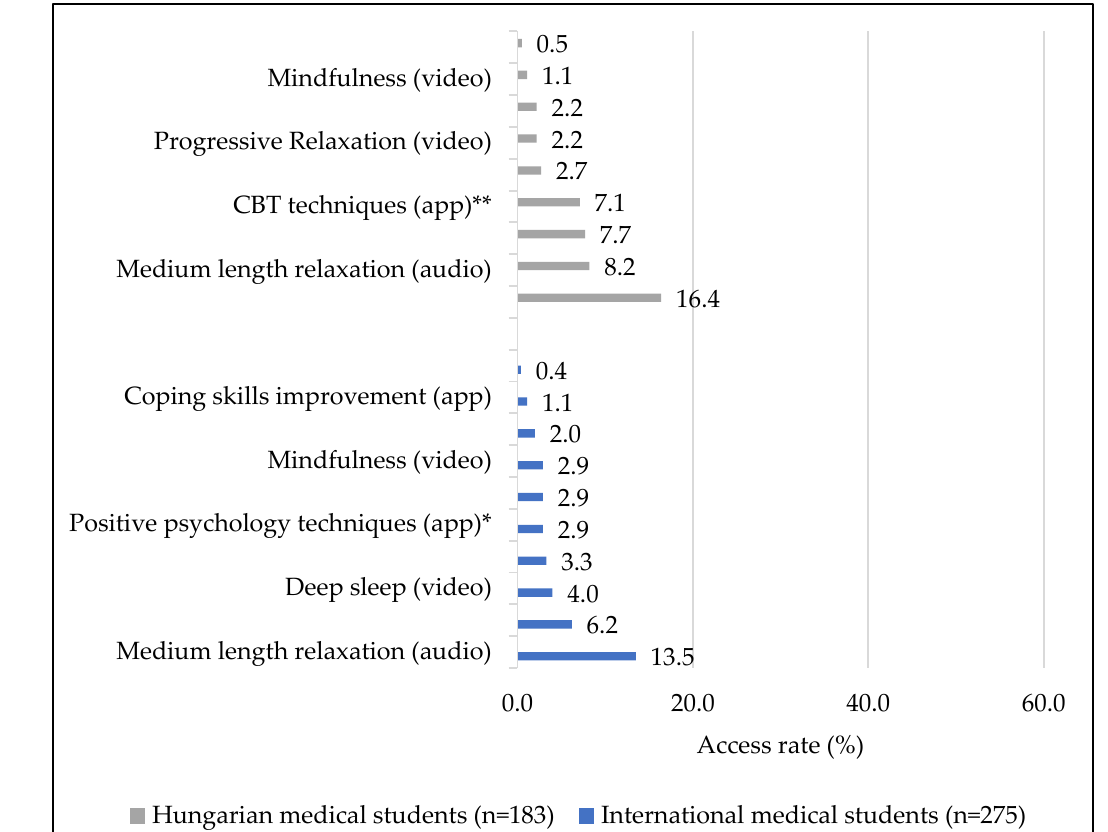
Figure 3. Access rate of study help contents separately by course type.